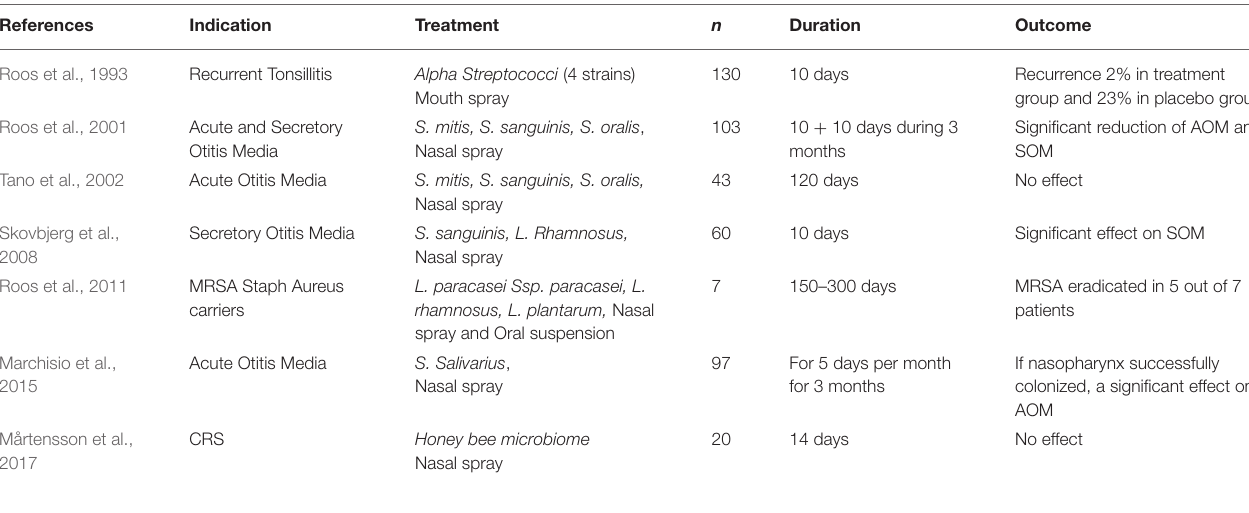
TABLE 1 | Topical probiotic intervention in ENT related